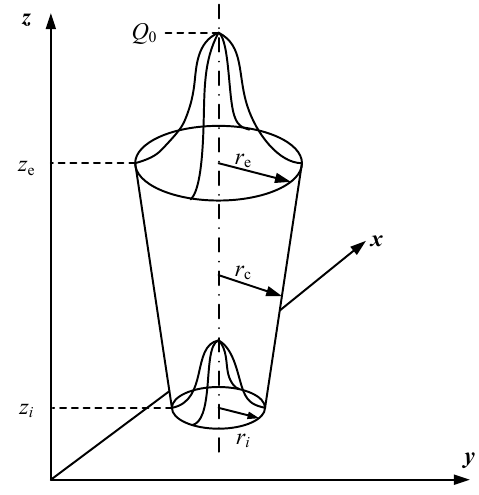
Figure 5. Conical heat source model.